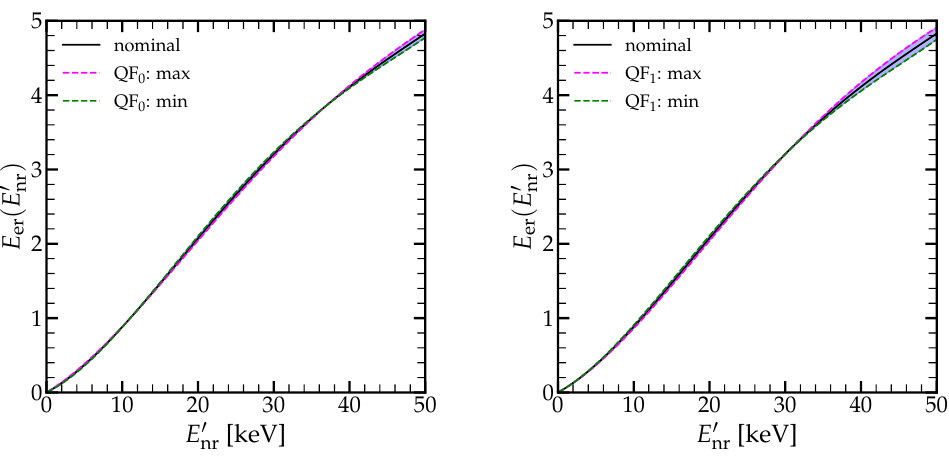
Figure 17 . COHERENT-CsI scintillation curve as function of the true nuclear recoil energy for the two QF models reported by COHERENT [8].